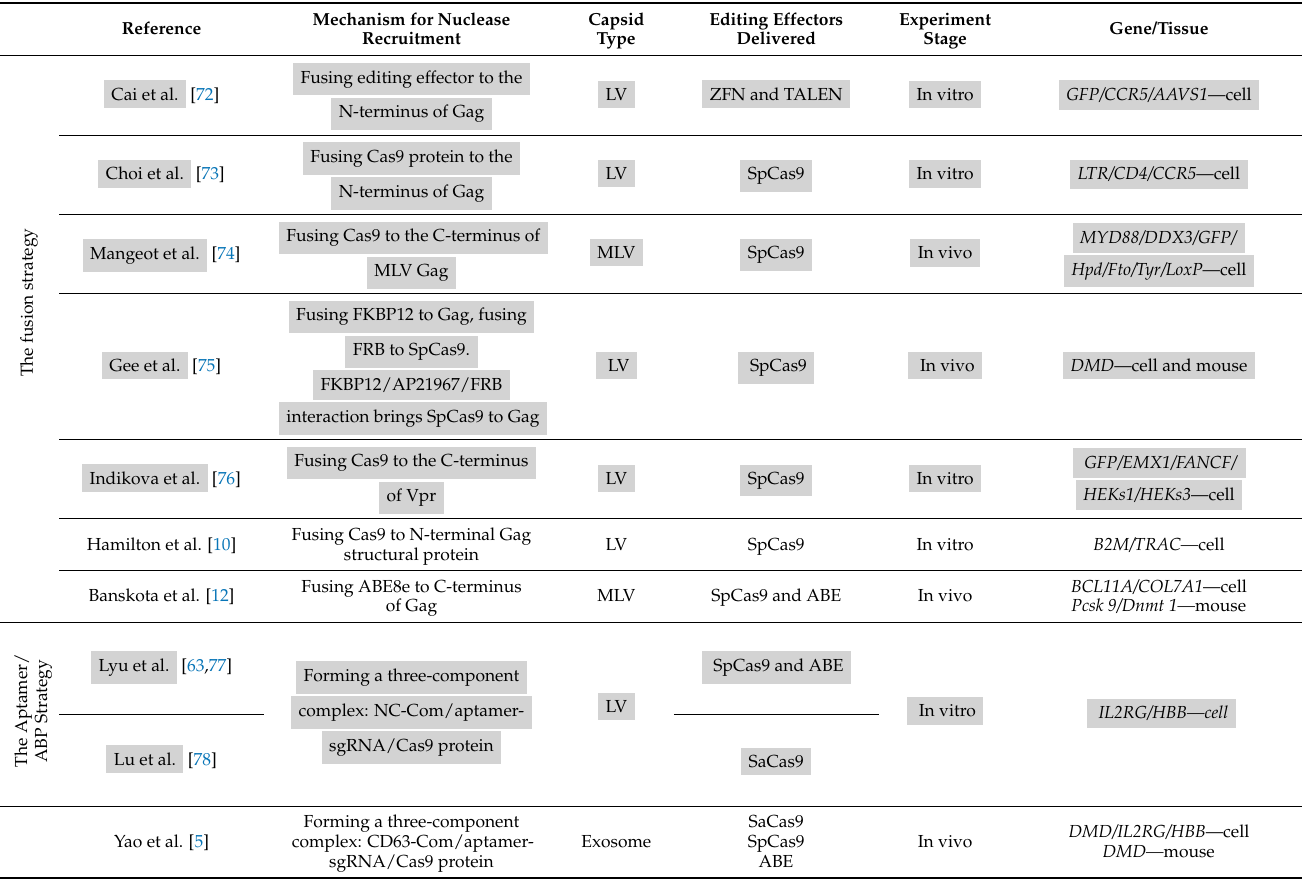
Table 2. VLP-mediated nuclease protein and RNP